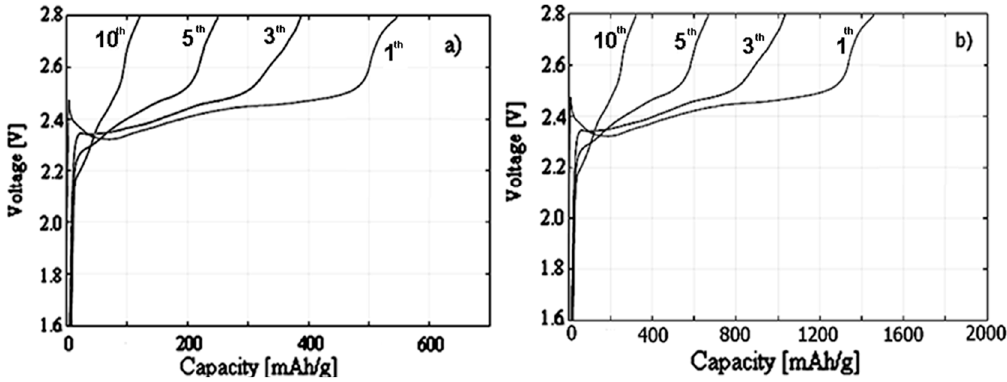
Figure 10. ( a ) Charge curves at C/10 for CS material; ( b ) charge curves at C/10 for SDR material.